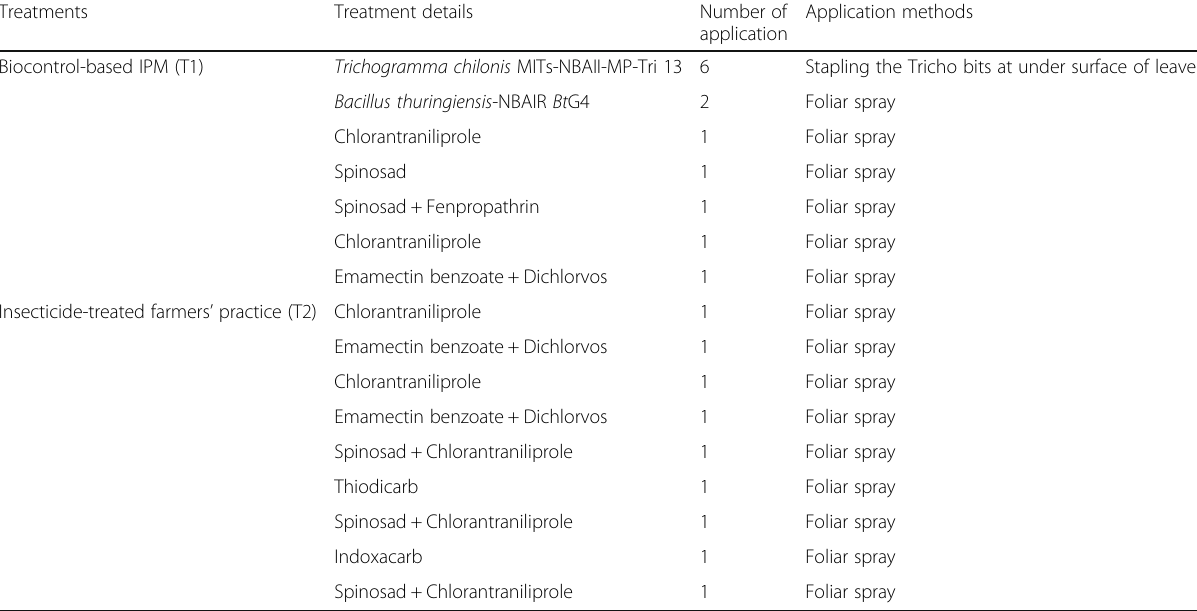
Table 1 IPM treatments and their application methods for controlling DBM in cabbage